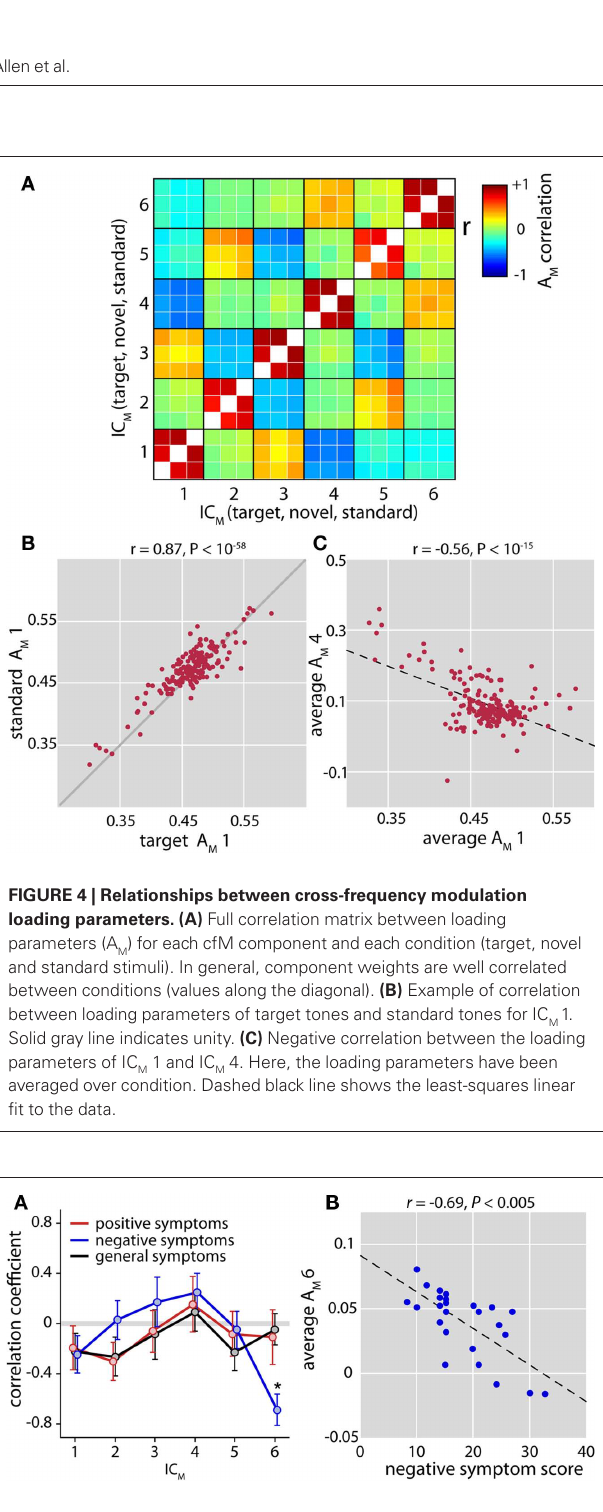
FiGuRE 5 | Relationship between cross-frequency modulation and patient symptoms. (A) Plot of correlation coefficients between IC M loading parameters (averaged over condition) and positive (red), negative (blue), and general (black) symptom scores. Only patients with PANSS scores collected within 2 weeks EEG acquisition were included in this analysis ( n = 25). Error bars ( ± 1 SEM) estimated with 1000 bootstrap resamplings. A single significant correlation (indicated by the asterisk, after Bonferroni correction for 18 tests) was found between negative symptoms and IC 6 ( r = − 0.69, P < 0.005). (B) Scatter plot of negative symptom M scores and the loading parameters of IC 6. Dashed black line represents M the least-squares linear fit.